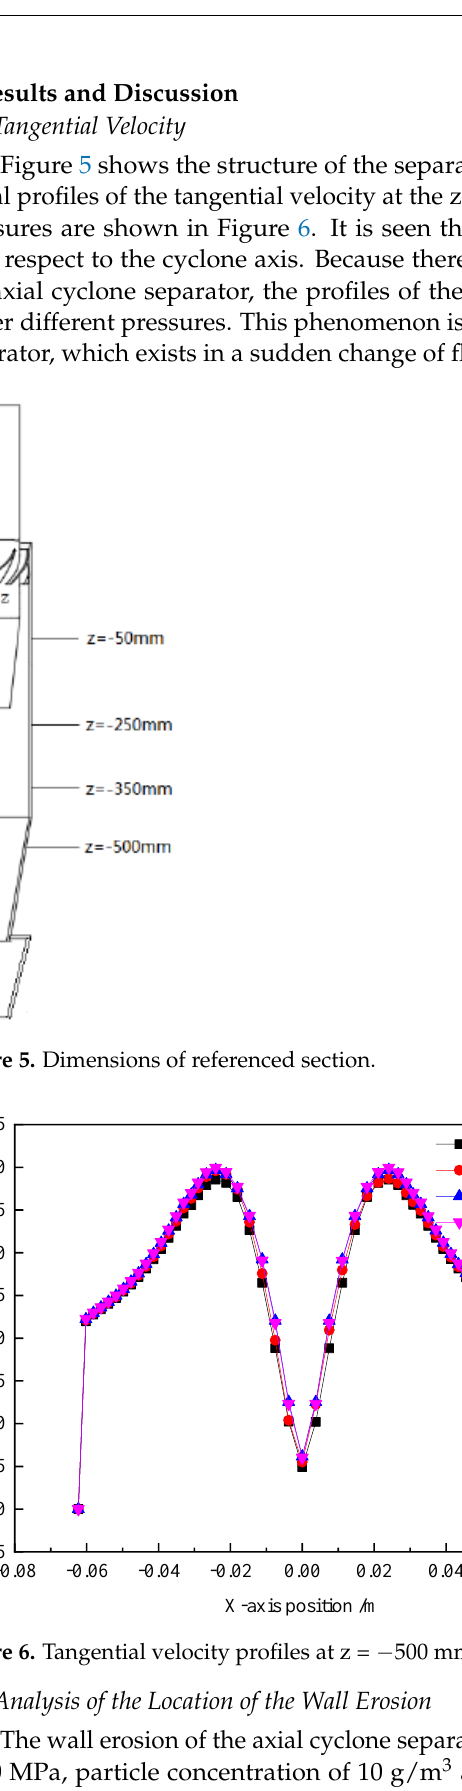
Figure 4. Validation of the simulation results [32].